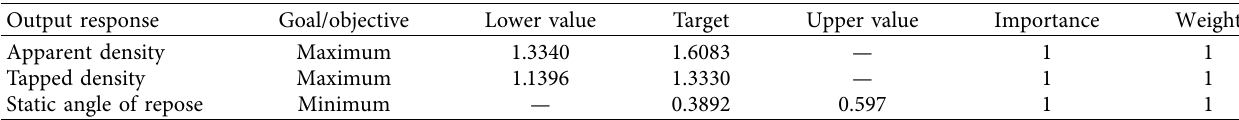
Figure 8: Surface plots for the static angle of repose. Table 6: Criteria for composite desirability